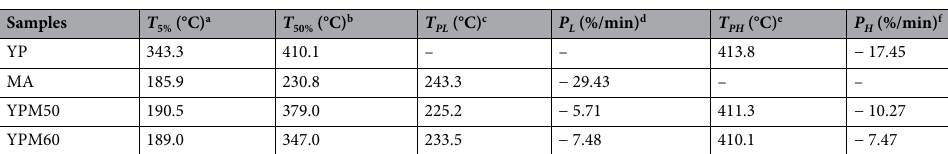
Table 1. The related TGA and DTG data of YP, YPM50, YPM60 and MA under nitrogen. a The testing temperature when the mass-loss of sample reaches 5 wt%, defined as the initial thermal-degradation temperature. b The testing temperature when the mass-loss of sample reaches 50 wt%. c The testing temperature of mass-loss peak at low temperature (the range of 0–300 °C). d The mass-loss rate of the mass-loss peak at low temperature (the range of 0–300 °C). e The testing temperature of mass-loss peak at high temperature (the range of 300–600 °C). f The mass-loss rate of the mass-loss peak at high temperature (the range of 300–600 °C).